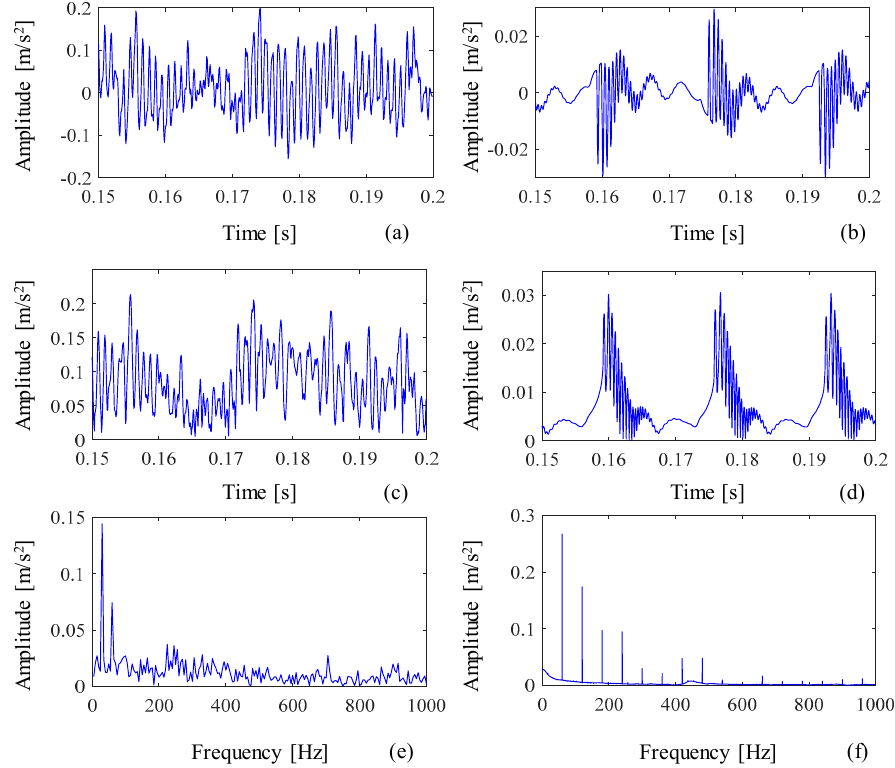
Figure 5. Real and simulation data in fault-free cases: ( a , c , e ) are the original data, the envelop data, and the frequency spectrum of the real envelop data; ( b , d , f ) are the original data, the envelop data, and the frequency spectrum of the simulation envelop data.